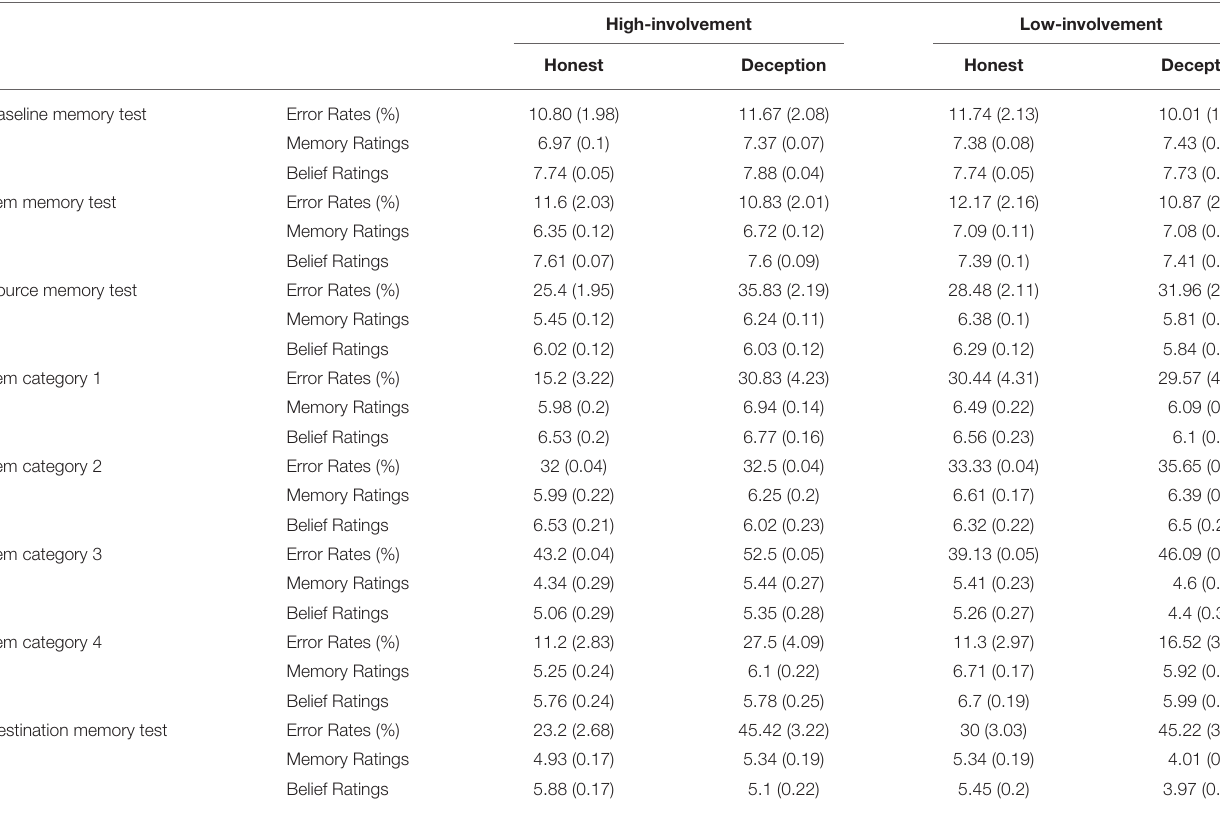
TABLE 1 | Mean error rates and ratings for correct responses in the memory tests for each